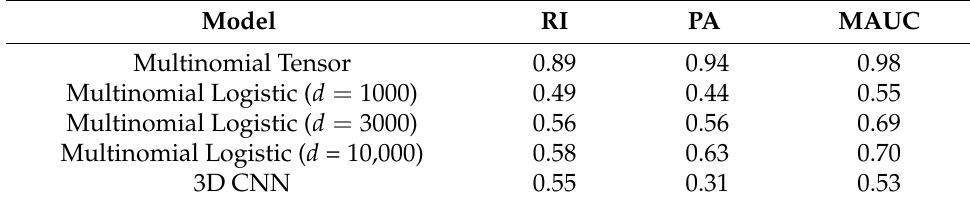
Table 3. The summary statistics for prediction performance on the testing set for all